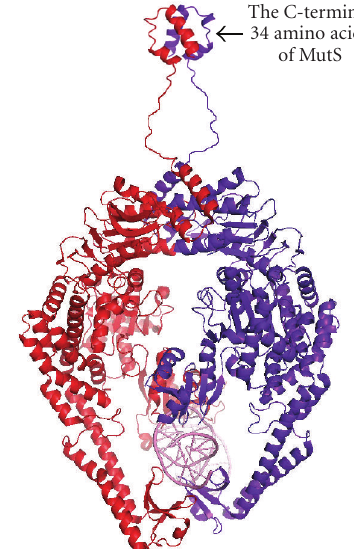
Figure 6: The model for full length of E. coli MutS dimer. The crystal structure of the C-terminal 34 amino acids of E. coli MutS (2OK2) [44] was connected to the C-termini of E. coli MutS (residues 2-800) structure